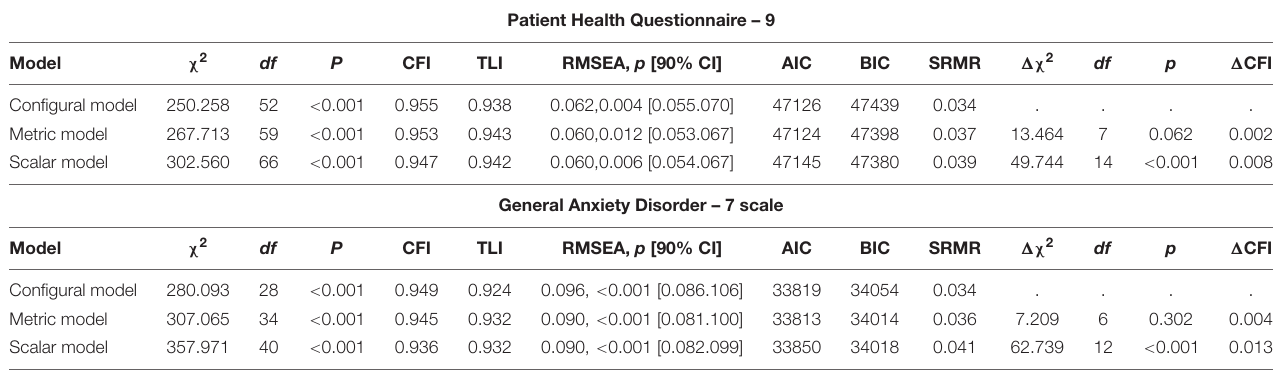
TABLE 2 | Measurement invariance testing the PHQ-9 and GAD-7: male and female.